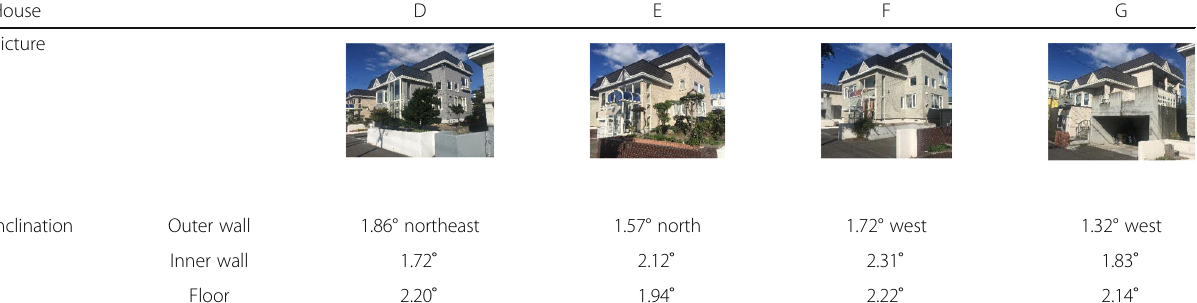
Table 3 Inclination of houses (Utsukushigaoka 1jo, D to G) House D